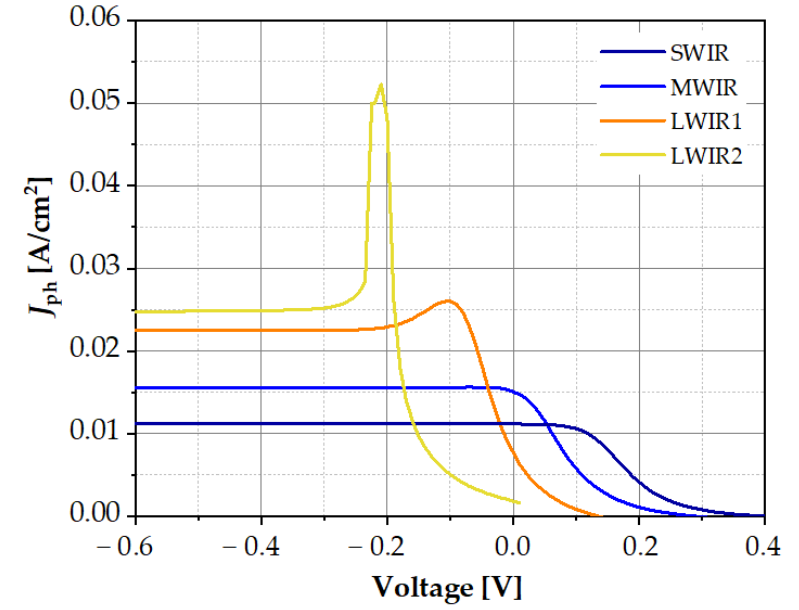
Figure 12. Photocurrent versus voltage for measured structures of different spectral ranges at T = 300 K. Finally, we compared the experimental values of the R 0 A product with its theoret- ical limits as a function of absorber composition x (Figure 13). The theoretical data are only based on Auger and radiative recombination. For all spectral ranges discussed, our experimental values are more than twice as low as the theoretical limits, so there is a possibility of further improvement of the constructed detectors. The R 0 A products for the LWIR detectors are the closest ones to their theoretical limits. Figure 13 also shows the R 0 A product experimental data taken from the literature [1] (see page